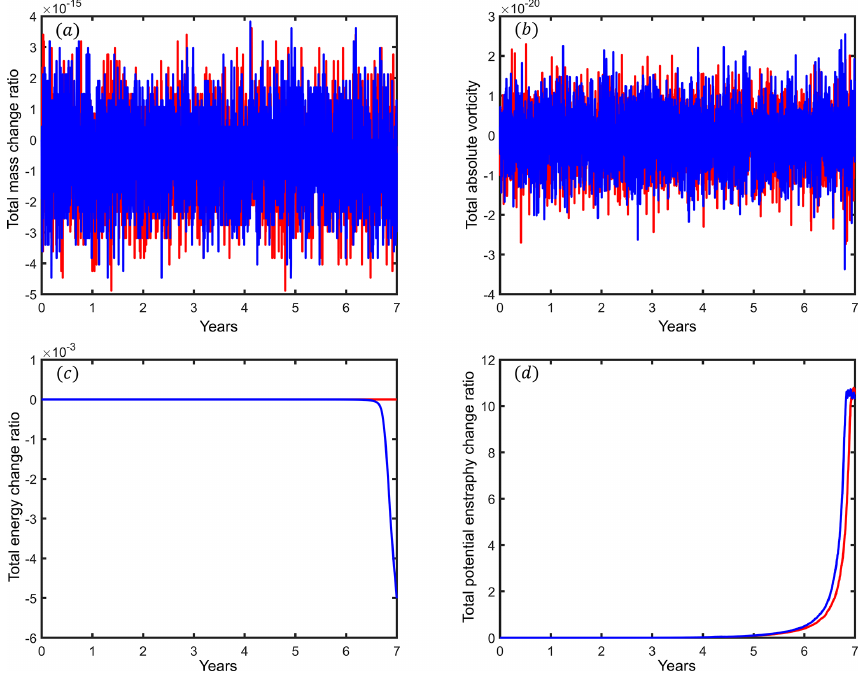
Figure 3. The variation of integral invariants as a function of time of SWTC2. (a) Total mass change ratio; (b) total absolute vorticity; (c) total energy change ratio; (d) total potential enstrophy change ratio. The results of RK4 are represented by blue lines; the results of NRK4 are represented by red lines. The model mesh is